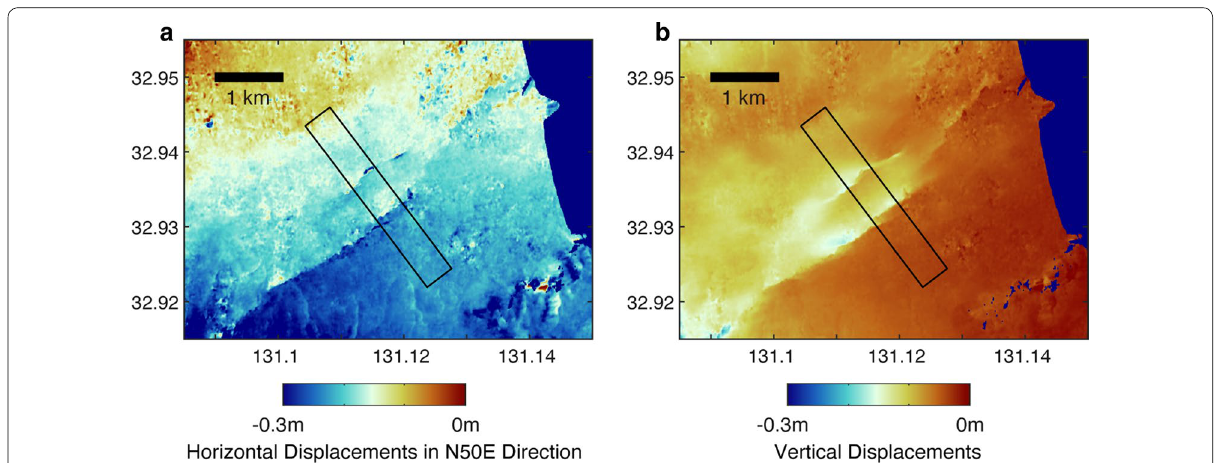
Fig. 4 a Horizontal N50 ◦ E and b vertical displacements around Miyaji faults. The rectangular boxes show the area where the profiles of Fig. 5 were taken